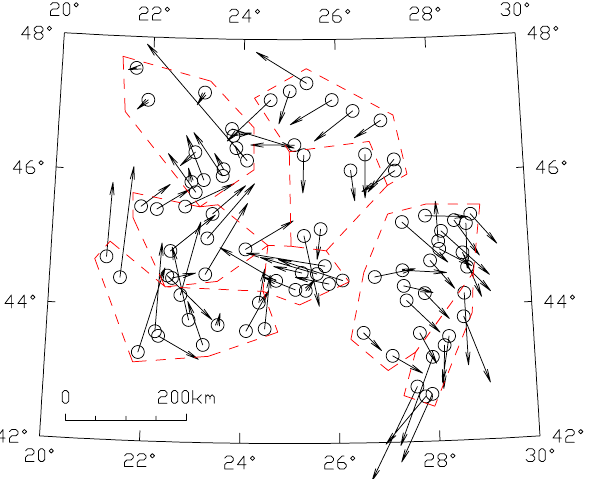
Figure 8. Simulated example: transformation units after MSS- method (run